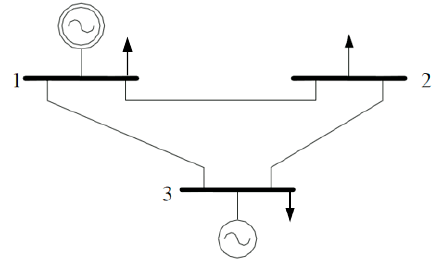
Figure 4. One-line diagram of IEEE 3-Bus.